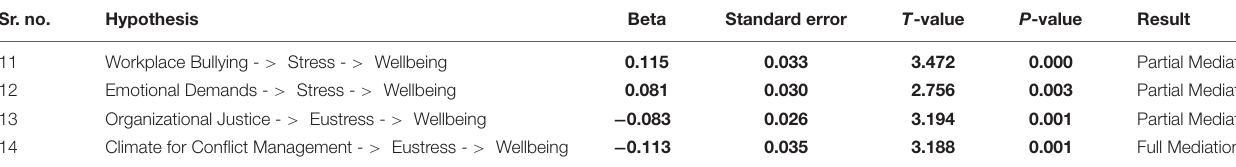
TABLE 5 | Indirect hypothesis testing. Sr.